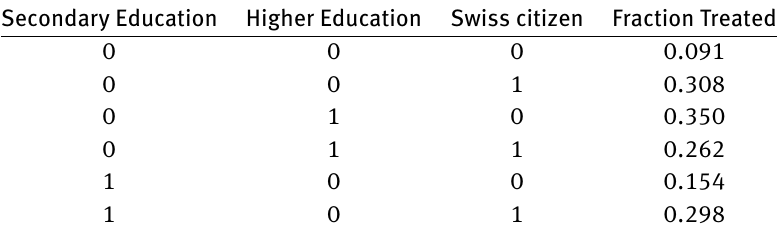
Table B1: Analysis of Common